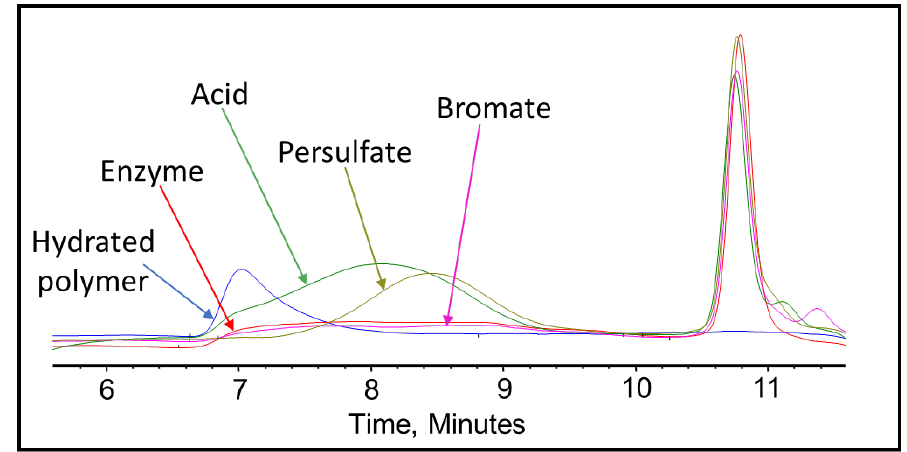
Figure 9. GPC results of the 45 lb/1000 gal crosslinked fracturing fluid exposed to different gel breakers